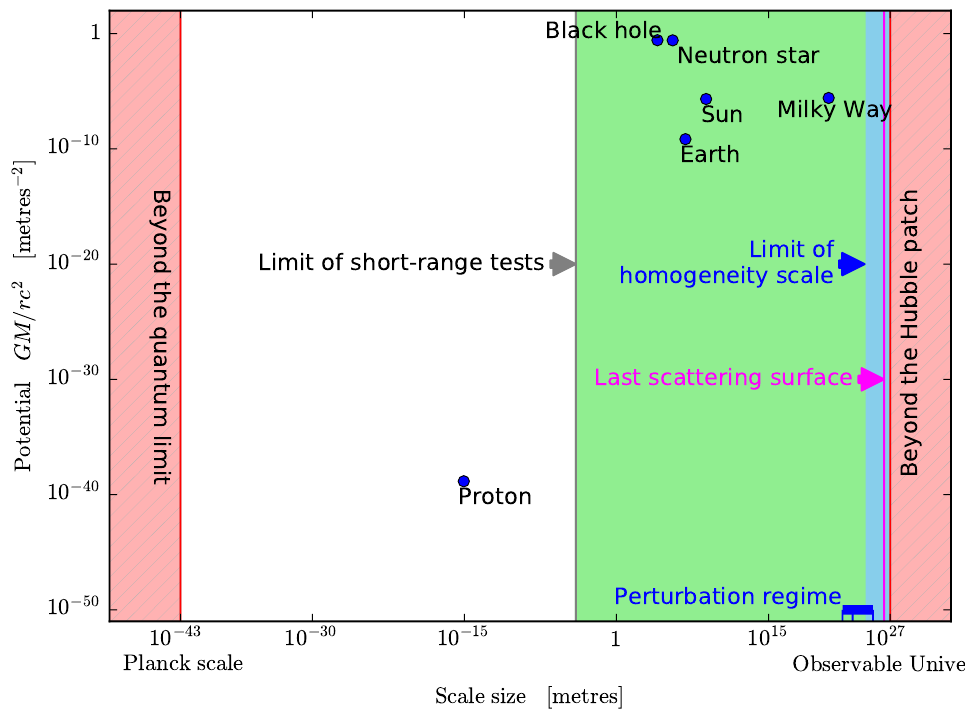
Figure 6. The parameter space for experiments. The horizontal axis is the typical length scale of the object in question. The vertical axis measures the gravitational potential. The red vertical line on the left-hand side marks the Planck scale. The vertical line on right-hand side of the plot marks radius of the observable universe, or Hubble radius. Experimental verification of GR is impossible beyond these limits. The radius of the surface of last scattering is only slightly smaller than our Hubble radius. Assuming GR implies assumptions far beyond the range that has been experimentally